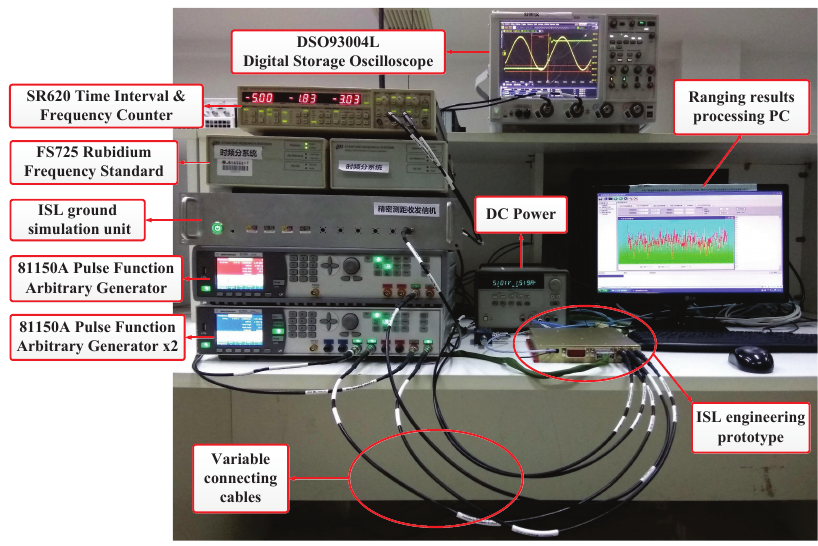
Figure 10. Experimental scenario of field data collection and ranging comparison.